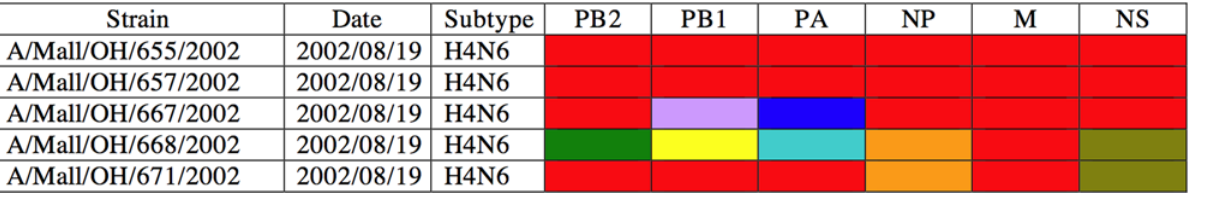
Figure 2. The genome constellations (internal gene segments only) of 5 H4N6 viruses collected from mallards at the same location in Ohio, USA on the same day. The different colors reflect segments whose sequences fall into different major clades – defined by strong bootstrap support ( . 80%) – in each internal gene segment tree. For example, all 6 internal gene segments from isolates A/Mall/OH/655/2002 and A/ Mall/OH/657/2002 have the same, shared phylogenetic position (shaded red), but exhibit a significantly different phylogenetic pattern, indicative of reassortment, with A/Mall/OH/667/2002 in the PB1 and PA gene segments (individual trees presented in Figures S4 and S5). Similarly, isolate A/Mall/ OH/668/2002 shows phylogenetic evidence of reassortment in 5 of 6 internal gene segments compared to